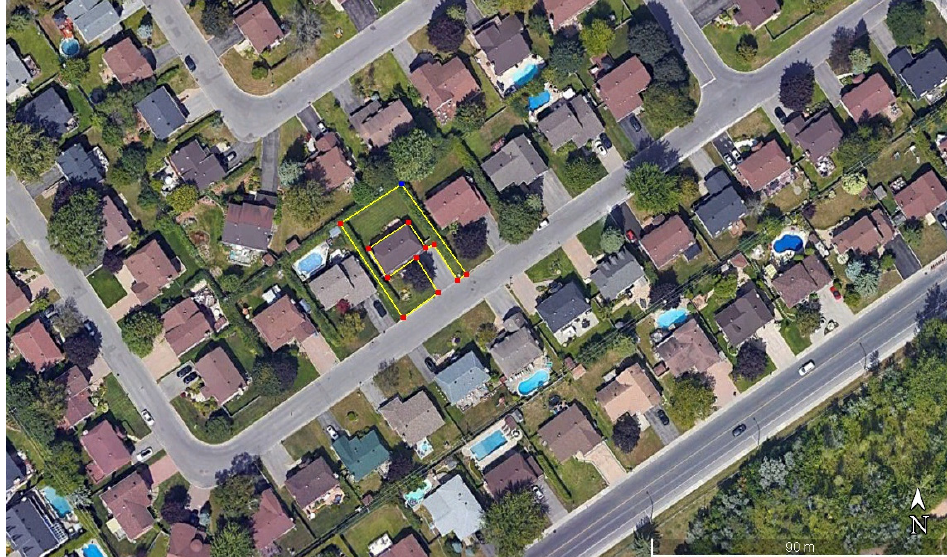
Figure 5. Typical landscape and garden of single-detached house in Dollard-des-Ormeaux. Source: Google Earth,